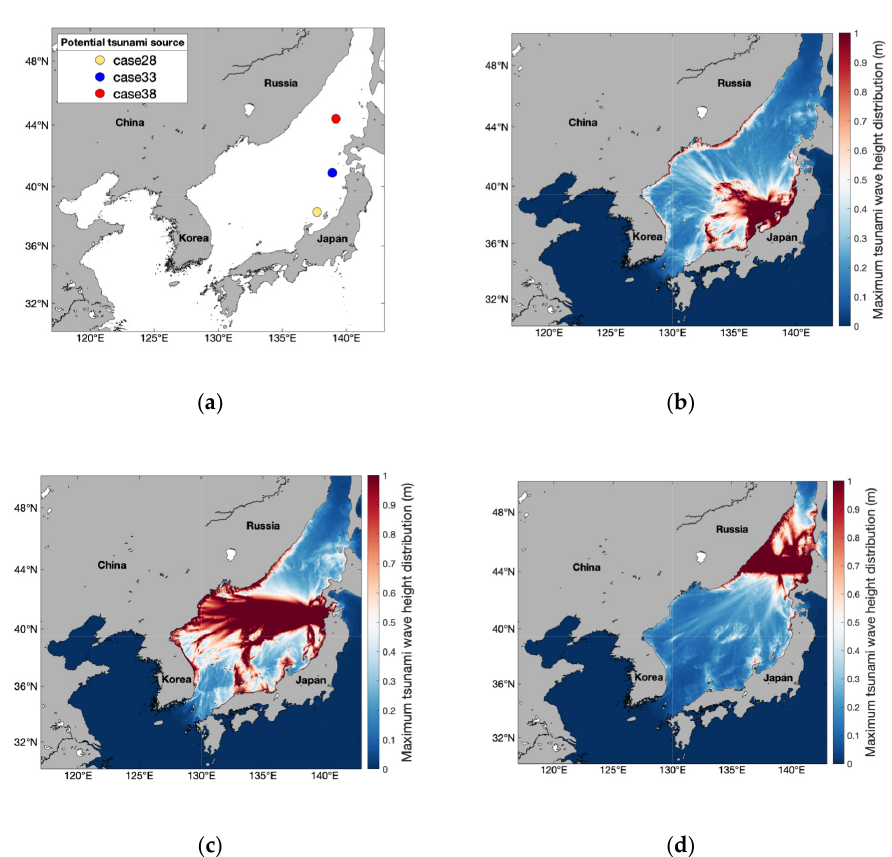
Figure 7. Comparison of maximum tsunami height distributions with the same fault parameters except source location and strike angle: ( a ) Location map of potential tsunami sources. Maximum tsunami height distributions are shown for ( b ) case28, ( c ) case33, and ( d ) case38.